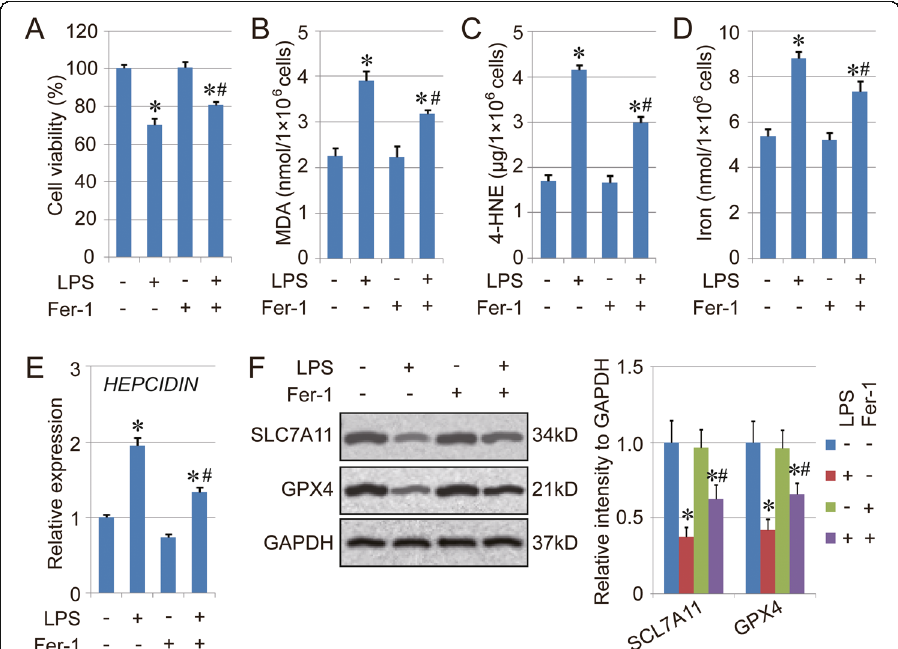
Fig. 2 Fer-1 attenuates LPS-induced cell injury. a . Cell viability of BEAS-2B cells treated with LPS and Fer-1. The cells were treated with LPS (10 mg/L) and Fer-1 (2 μ M) for 16 h, then the cell viability of each group was measured using CCK-8. b - d . Levels of MDA (B), 4-HNE (C) and total iron (D) in the BESA-2B cells treated with LPS. e . mRNA expression of HEPCIDIN . f . Protein levels of SLC7A11 and GPX4 in the BESA-2B cells treated with LPS. Results are expressed as means±SEM ( n = 3). *: p < 0.05 compared with the control group. #: p < 0.05 compared with the LPS